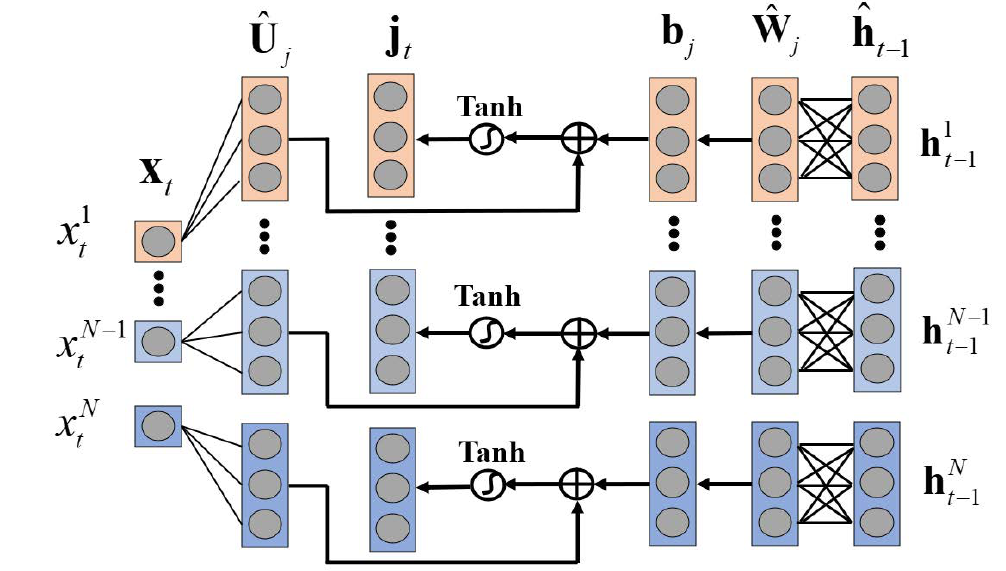
Figure 1. The updating process of hidden update j t